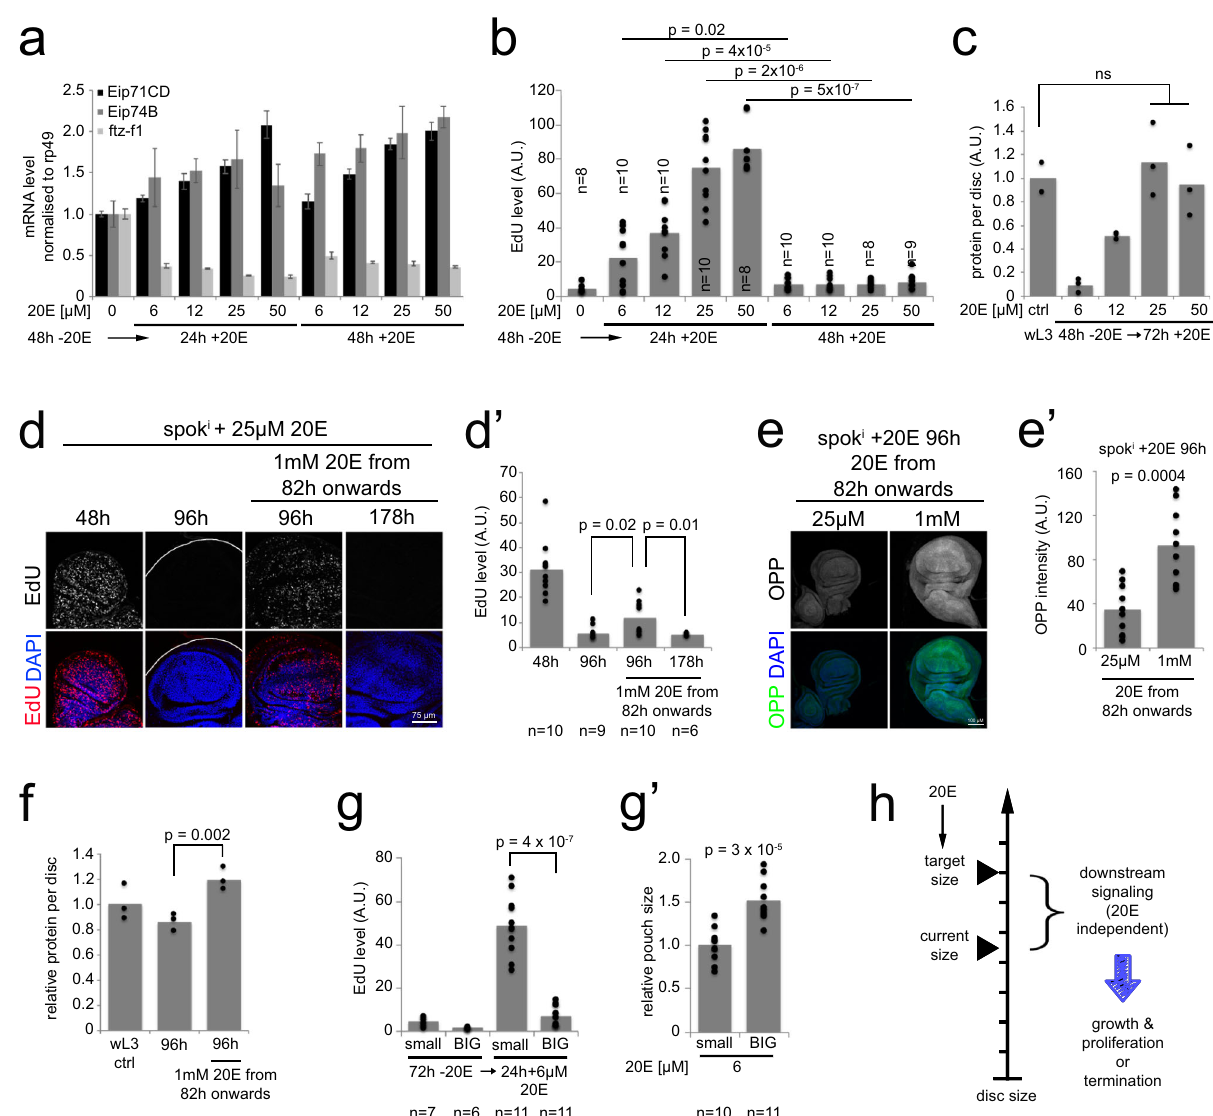
Fig. 2 Ecdysone signaling does not decrease when wing discs stop proliferating, but it affects the target size. a – b Ecdysone signaling does not change when Tub ts > spok i + 20E discs stop proliferating. Knockdown of spok i (Tub ts > spok i ) was induced 48 h prior to feeding larvae with 6 – 50 µ M 20E in order to start with a low baseline. a Ecdysone target gene expression was measured by Q-RT-PCR 24 h and 48 h after 20E feeding, whereby Eip71C and Eip74B are induced by 20E and ftz-f1 is repressed by 20E. n = 10 discs/condition. Representative of two biological replicates. Bar = mean. Error bars = std. dev. b For all ecdysone signaling levels, Tub ts > spok i + 20E discs stop proliferating by 48 h after 20E supplementation, measured by EdU incorporation. Representative of two biological replicates. c – f Final disc size depends on ecdysone concentration. c A titration of 6 – 50 µ M 20E was fed to Tub ts > spok i larvae as in ( a – b ). Disc size is assayed as total protein per disc by BCA protein measurement 72 h after 20E feeding. n = 6 discs/sample. Representative